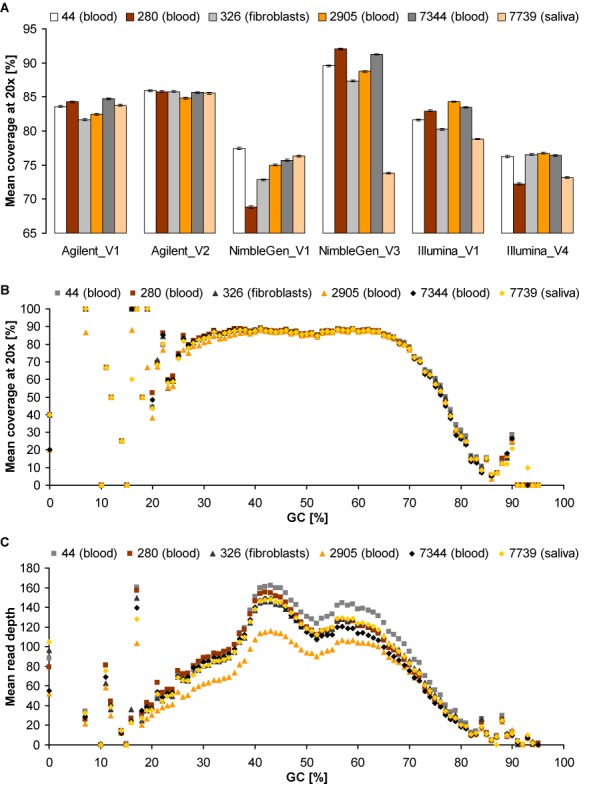
Differences among DNA samples. (A) Mean coverage of RefSeq exons (n = 233 644) at 20× (expressed in percentage of the entire exon length) for all six platform-vendor combinations and DNA samples (44, 280, 326, 2905, 7344 and 7739) derived from blood, fibroblasts or saliva. Values were obtained by using the SeqMonk program (www.bioinformatics.babraham.ac.uk/projects/seqmonk) and are presented in Supplementary Tables S6 and S12. Error bars indicate 95% confidence intervals for the arithmetic means of all corresponding exons. (B and C) Mean coverage at ≥20 reads (B) and mean read depth (C) of RefSeq exons per GC content for each DNA sample exemplified by the WES data of V2 using Agilent, demonstrating its high performance stability across samples.